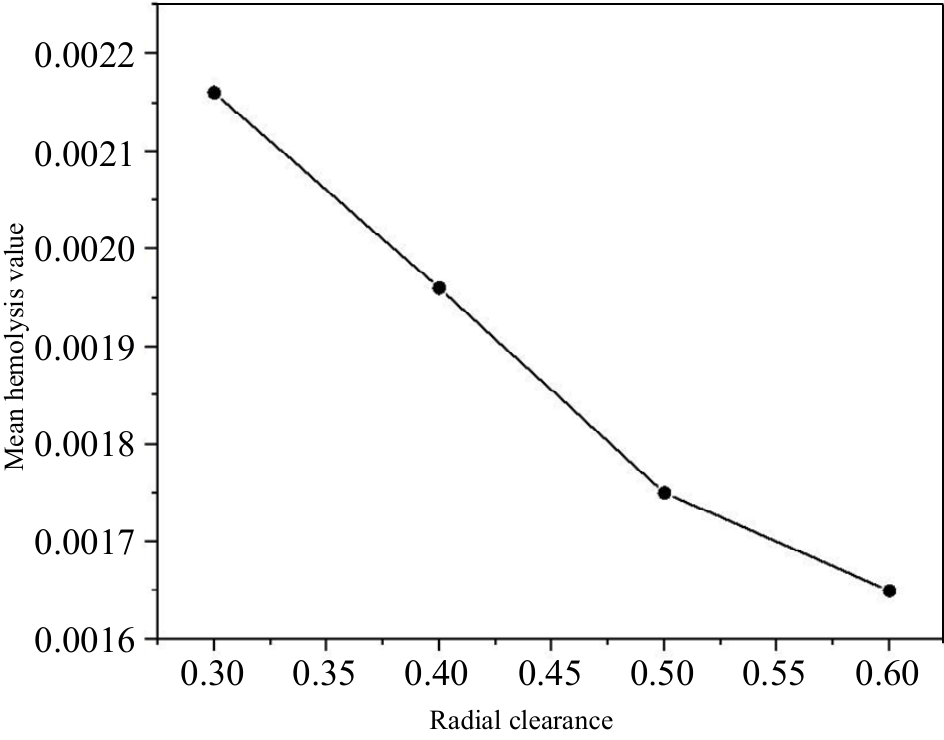
Figure 15. Relationship between the clearance and the hemolysis prediction